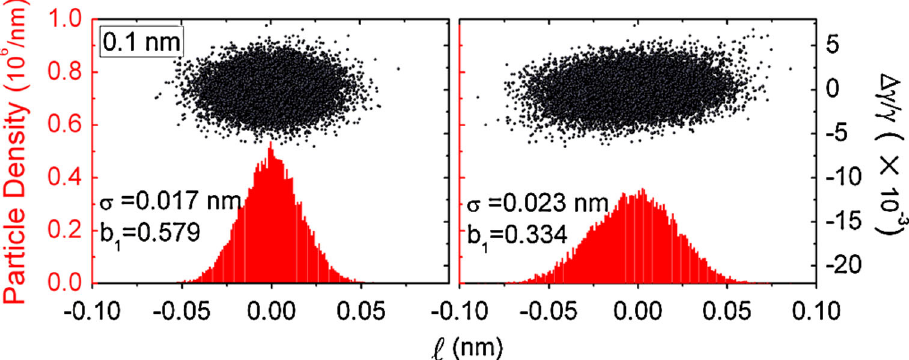
FIG. 10. (Color) Microbunch before (left) and after (right) a bend comprised by eight repetitive cells. The initial microbunch is assumed to be Gaussian with full length ( 6 (cid:5) ) of 0.1 nm. 20 000 sample electrons have been tracked using the code ELEGANT